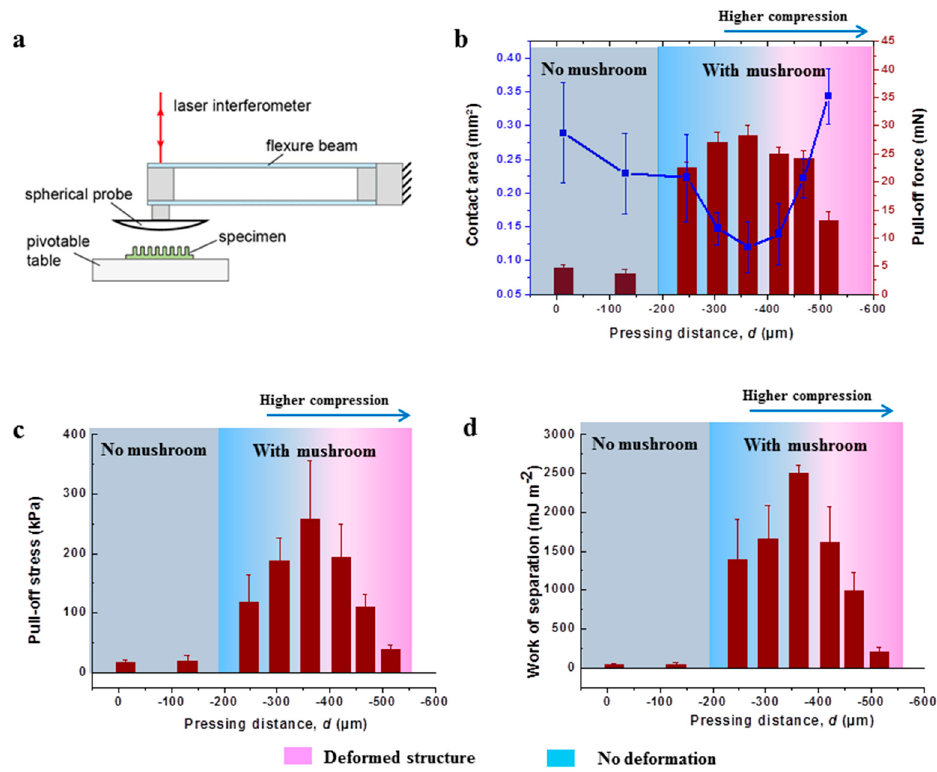
Figure 3. Adhesion test setup and results. ( a ) Illustration of the adhesion test device. ( b ) The pull-off force (red bars) and the contact area (blue squares) in terms of the distance between template and wet coating during roll-to-roll fabrication; the measured pull-off stress and work of separation are shown in ( c ) and ( d ), respectively. Error bars correspond to the standard deviation of the adhesion test.